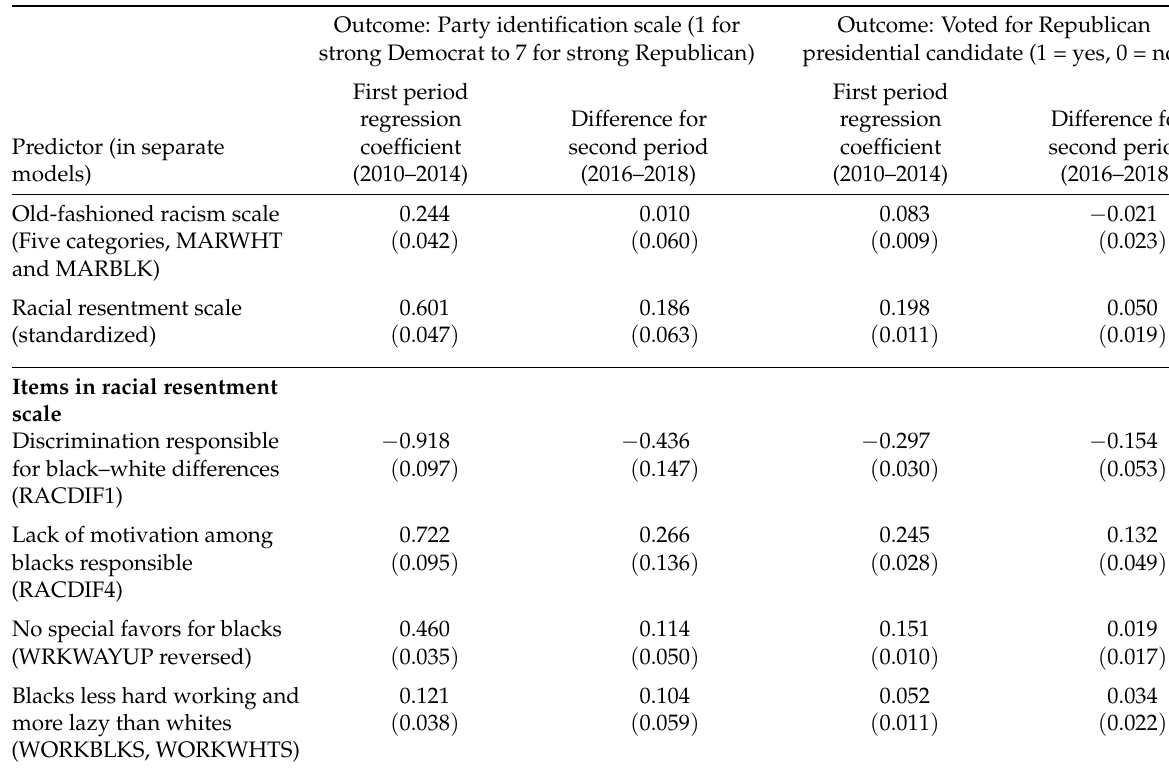
Table 3: Results from 12 least squares models of change in the net predictive power of measures of old- fashioned racism and racial resentment for white-only, non-Hispanic